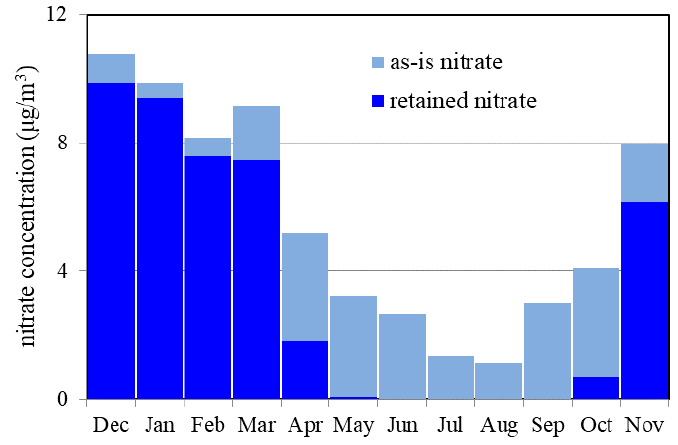
Figure 11. Forecasted monthly mean as-is and retained PM 2.5 nitrate at Bulkwang PM 2.5 supersite in Korea from December 2015 to November 2016.